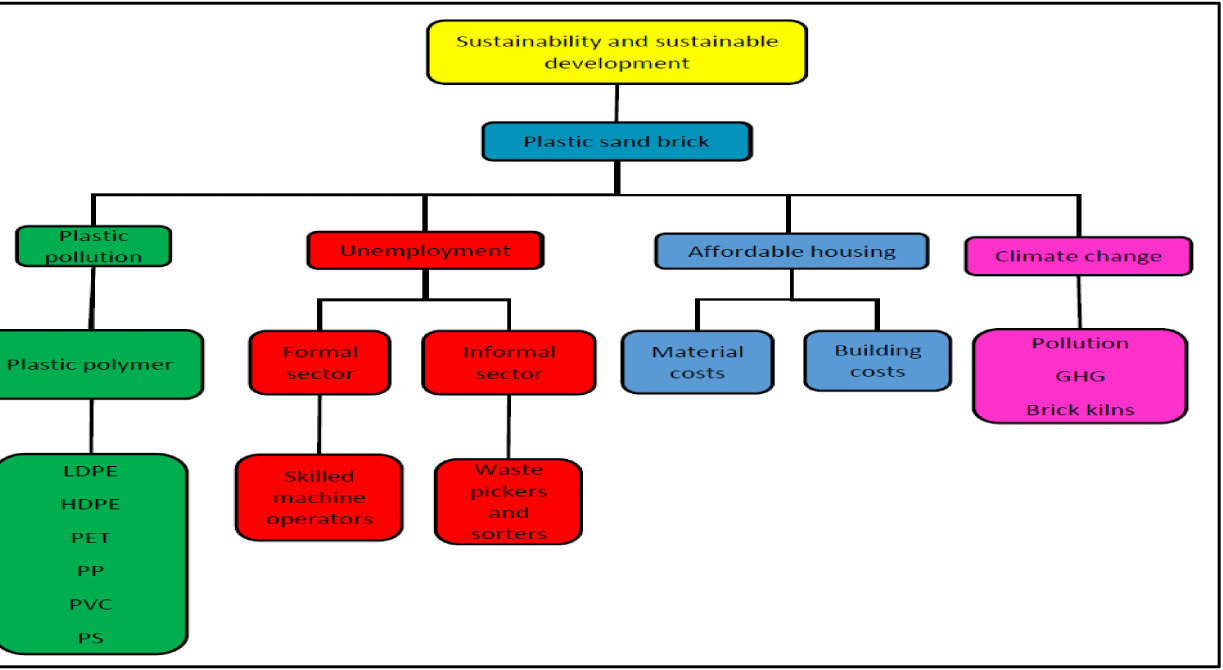
Figure 1. Flowchart of the